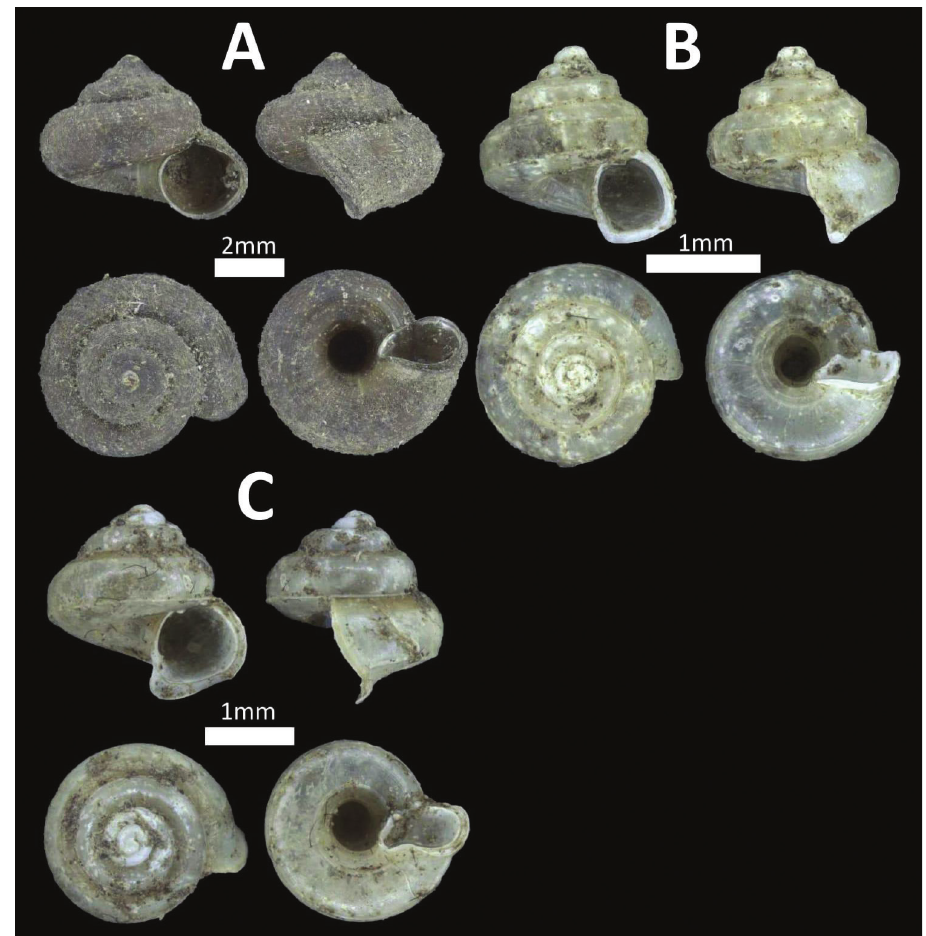
Figure 4. Family Cyclophoridae. A Japonia keppeli (BOR/MOL 10027) B Ditropopsis koperbergi (BOR/ MOL 8455) C Ditropopsis imadatei (BOR/MOL 10358).